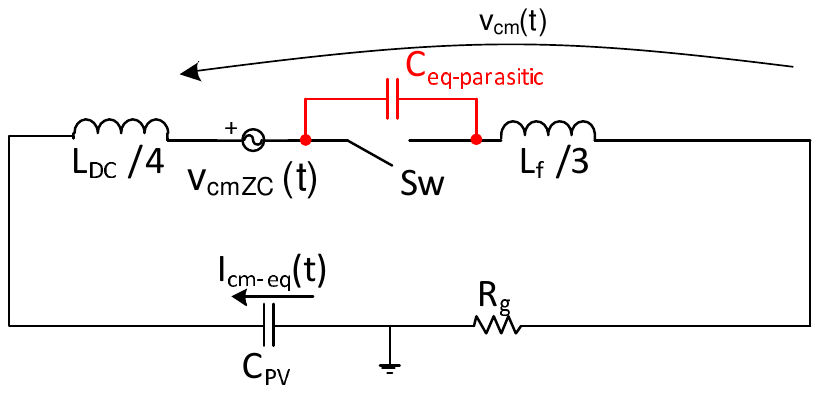
Figure 6. Equivalent common-mode circuit considering parasitic